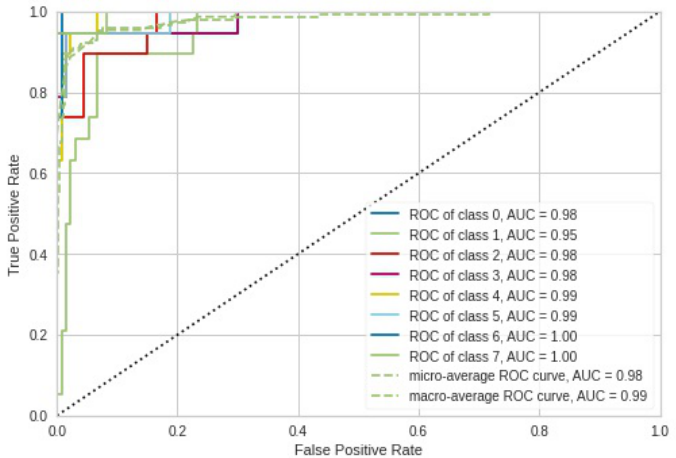
Figure 15. Support-Vector-Machine-based confusion matrix.